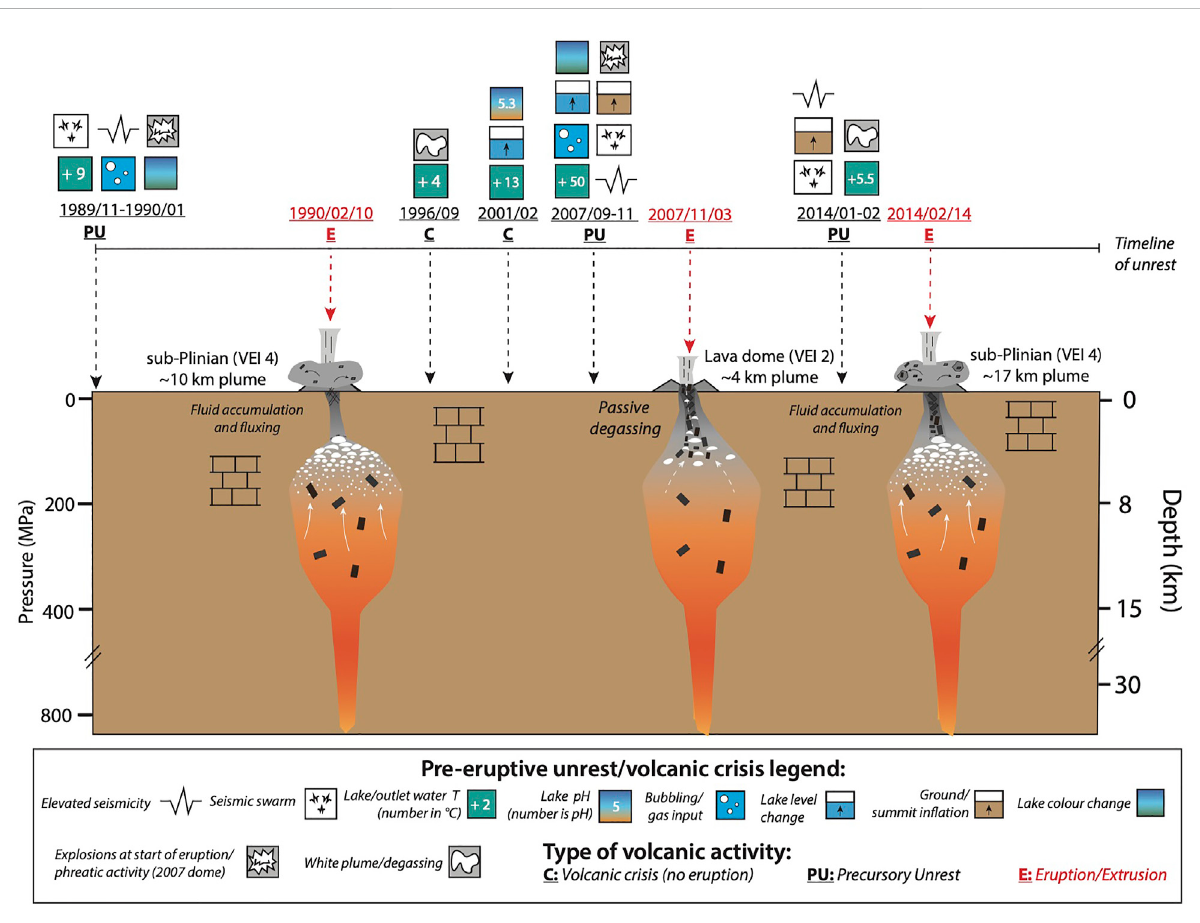
FIGURE 7 Conceptualmodeloftheproposedmagmaticconditionsandprocessesoccurringforthe1990 – 2014eruptions.Blackrectanglesinthemagma reservoirs represent the crystal cargo or crystallization in the conduit. White fl attened circles represent accumulation of the pre-eruptive exsolved fl uid phase. Solid white arrows represent fl uid fl uxing through the system either from a deep-seated degassing basaltic magma, or from limestone assimilation for explosive eruptions. Dashed white arrows represent fl uid release through a semi-permeable conduit leading up to dome extrusion. Symbols and codes are listed in the legend. Storage pressures are converted to depth below the crater using the density calculated in Smyth et al. (2007). The volcaniclastic and carbonate layers are taken from Jeffery et al. (2013), and references therein. Volcano Explosivity Indices (VEI)reportedcomefromGlobalVolcanismProgram(2013).PlumeheightarereportedinBourdieretal.(1997a)for1990;GlobalVolcanismProgram (2008) for 2007 lava dome; and Kristiansen et al. (2015) for 2014. Timeline for volcanic unrest is provided for the 1990 eruption (Global Volcanism Program, 1990a; Global Volcanism Program, 1990b; Lesage and Surono, 1995; Vandemeulebrouck et al., 2000), 2007 dome extrusion (Global Volcanism Program, 2008; Caudron et al., 2012; Lubis, 2014; Hidayati et al., 2019), and 2014 eruption (Global Volcanism Program, 2014; Hidayati et al., 2019), as well as the inter-eruptive unrest in 1996 and 2001 (Global Volcanism Program, 1990a; Global Volcanism Program,